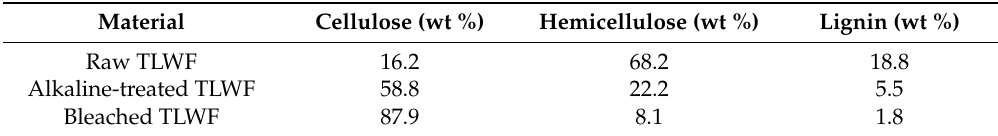
Table 1. Chemical composition of raw TLWF and treated TLWFs.